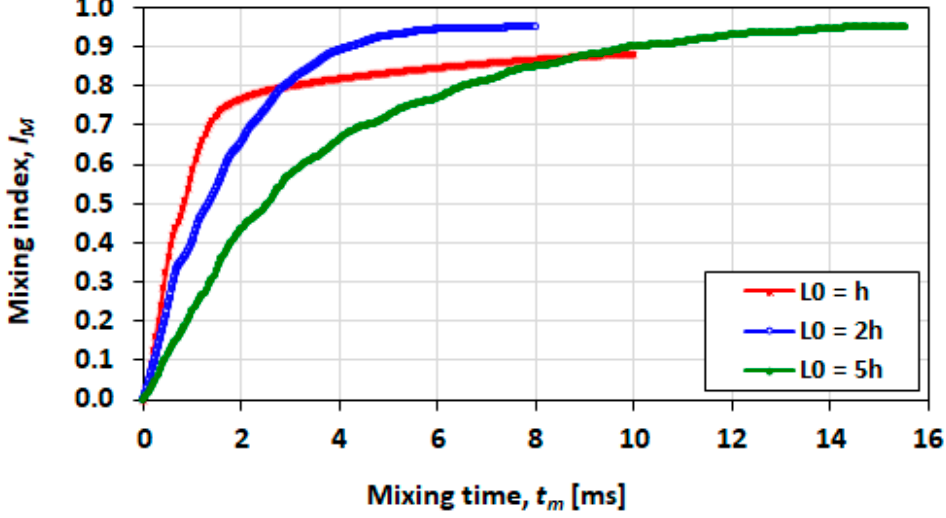
Figure 25. Comparison of mixing indexes for droplets with initial lengths of h , 2 h and 5 h at conditions of Ca = 0.21 and λ = 0.5 .